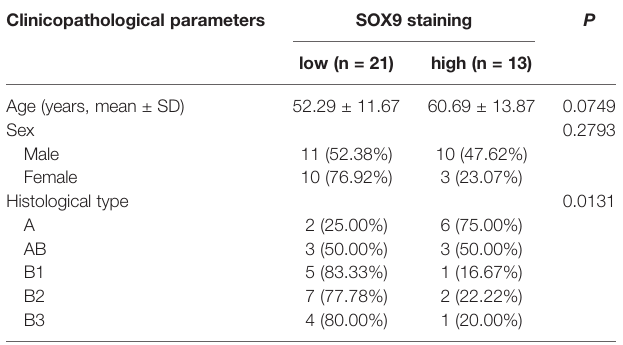
TABLE 1 | Correlation between SOX9 protein expression level and clinicopathological parameters of patients with thymomas in our cohort. Clinicopathological parameters SOX9 staining